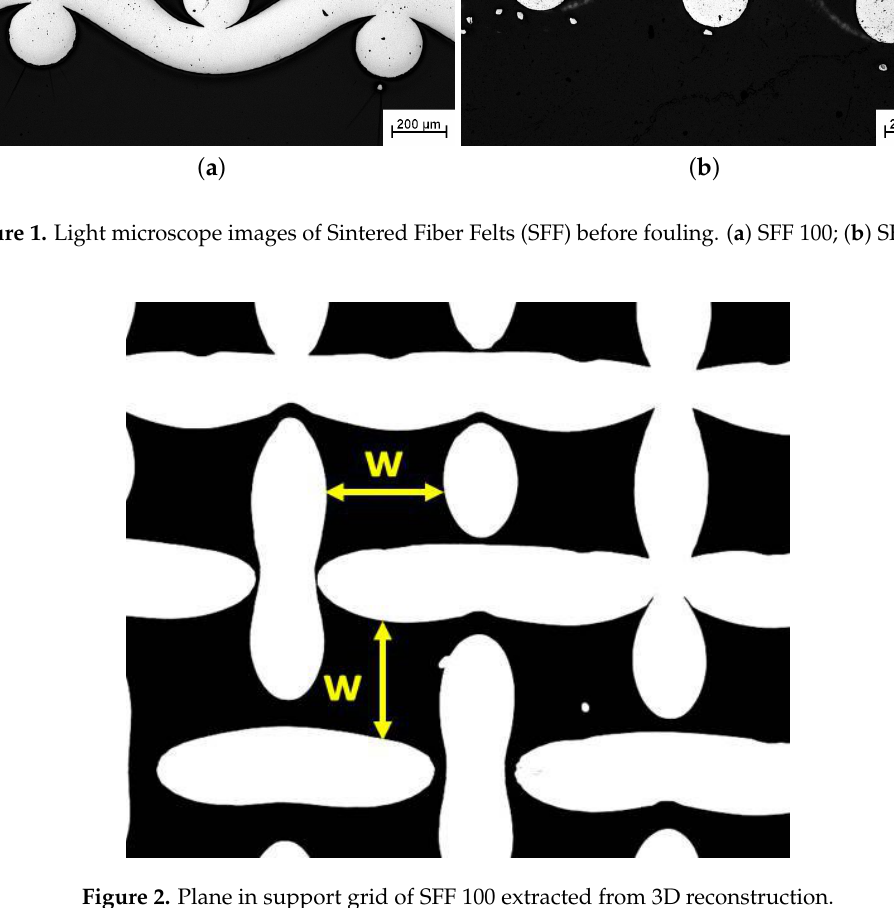
Figure 2. Plane in support grid of SFF 100 extracted from 3D reconstruction. Table 1. Structural parameters of sintered fiber felts in clean condition. Porosity φ f of the functional layer, thickness of the functional layers t f , fiber diameter in the functional layer d f , wire diameter of the support grid d w , mesh size of the support grid w , porosity of the support grid φ w , hydraulic radius of the support grid R h